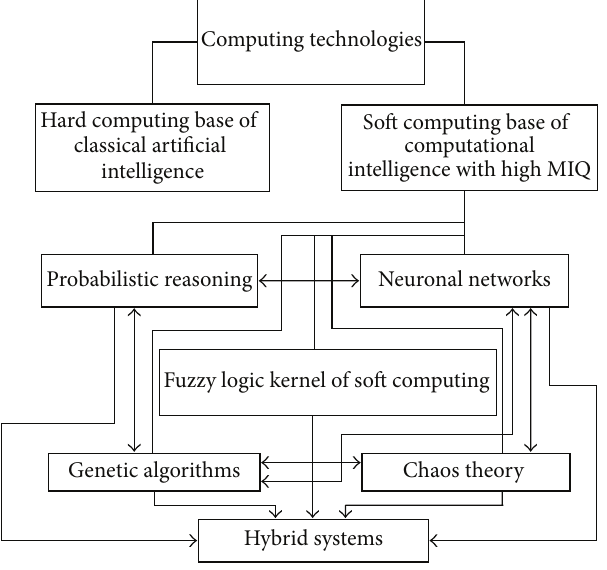
Figure 1: Soft computing